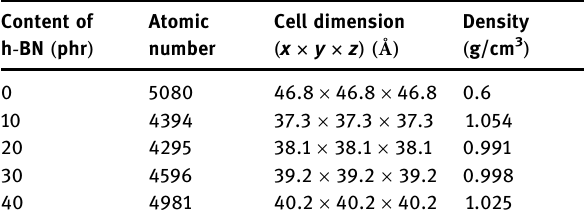
Table 1: Structural parameters of the initial model Content of h - BN ( phr